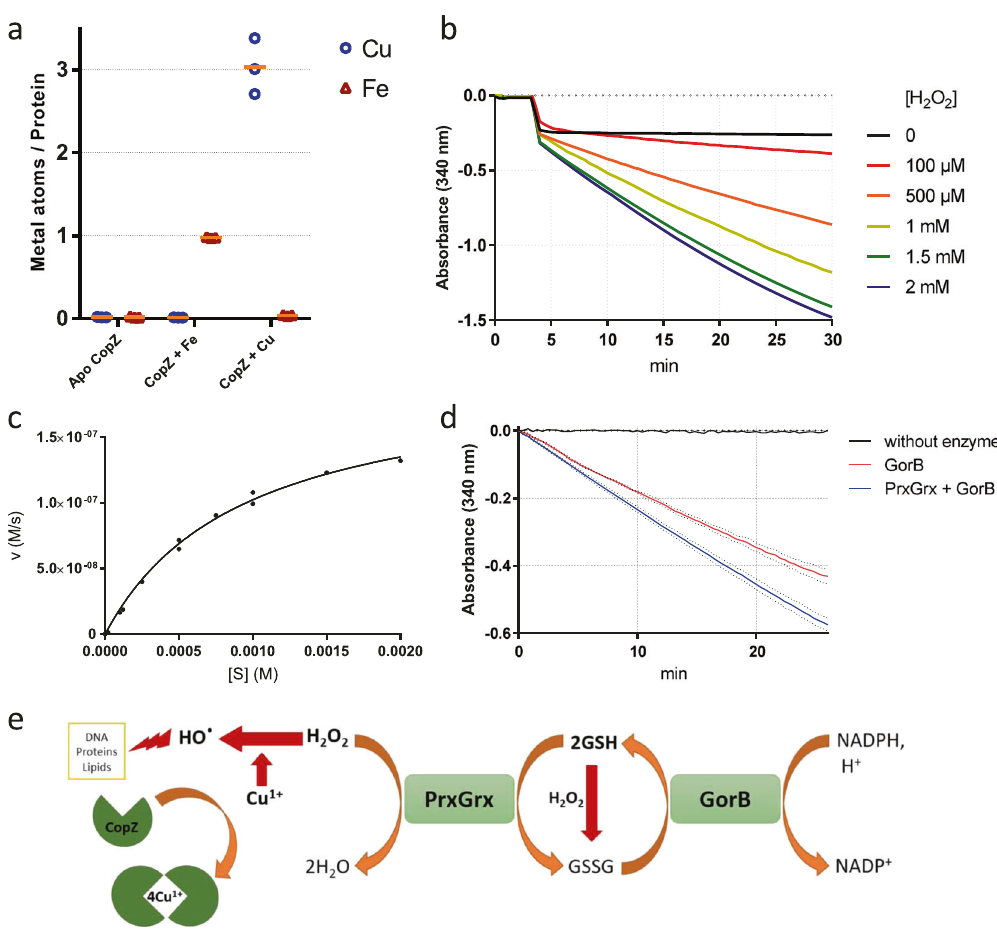
Fig. 5 Activities of the proteins coded by the bp1727-1728-1729 ( copZ-prxgrx-gorB) operon. a The metal/protein ratios of recombinant CopZ were determined by ICP-AES. The apo form of CopZ was incubated or not with iron (gray) or copper (black), and both ions were measured. Three independent samples were processed. b Oxidation of NADPH by recombinant GorB over time. H 2 O 2 was added at the indicated concentrations to generate the glutathione disul fi de (GSSG) substrate of GorB, before adding the enzyme. The reaction was followed by the decrease of absorbency at 340 nm. c Plot of the reaction rate as a function of substrate concentration. A k cat /Km value of 323,000 ± 46,000 M − 1 s − 1 for GSSG was estimated based on Michaelis – Menten kinetics. One or two measurements were performed at each substrate concentration. d Effect of recombinant PrxGrx on the rate of oxidation of NADPH by GorB. The red and blue curves show reaction rates when GorB was present alone or when both enzymes were present, respectively. H 2 O 2 was added last as a substrate of the fi rst reaction. However, as H 2 O 2 also generates GSSG, which initiates the second reaction, PrxGrx activity was detected by the increased rate of the reaction when both enzymes are present, and no enzymatic constants could be determined. ( e ) Schematic representation of the functions of the three proteins. By chelating Cu 1 + , CopZ prevents the ion from generating hydroxyl radicals through the Fenton reaction. H 2 O 2 is reduced to H 2 O through the activity of PrxGrx, at the expense of reduced glutathione (GSH). The product of that reaction, glutathione disul fi de, is reduced through the activity of GorB at the expense of